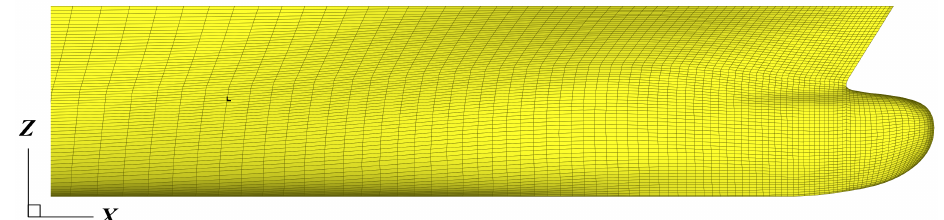
Figure 2. Hull surface mesh of KCS and the coordinate system for hull form